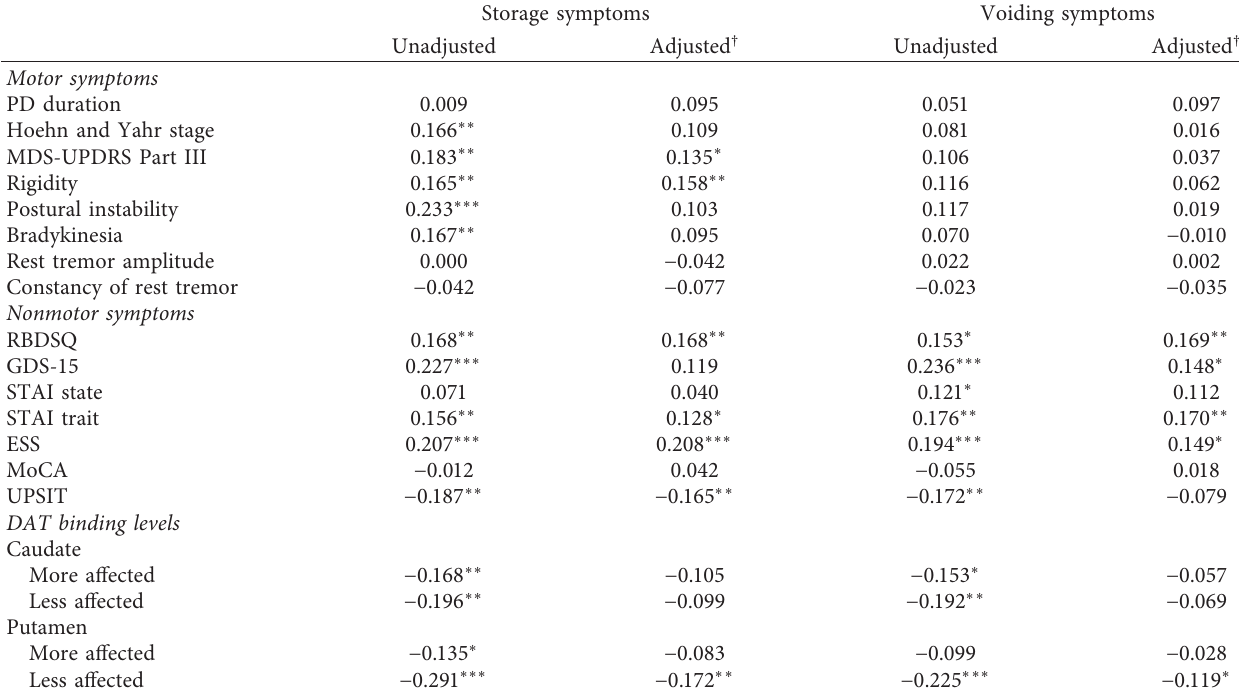
Table 2: Coefficient of correlation between urinary symptoms and clinical characteristics in patients with